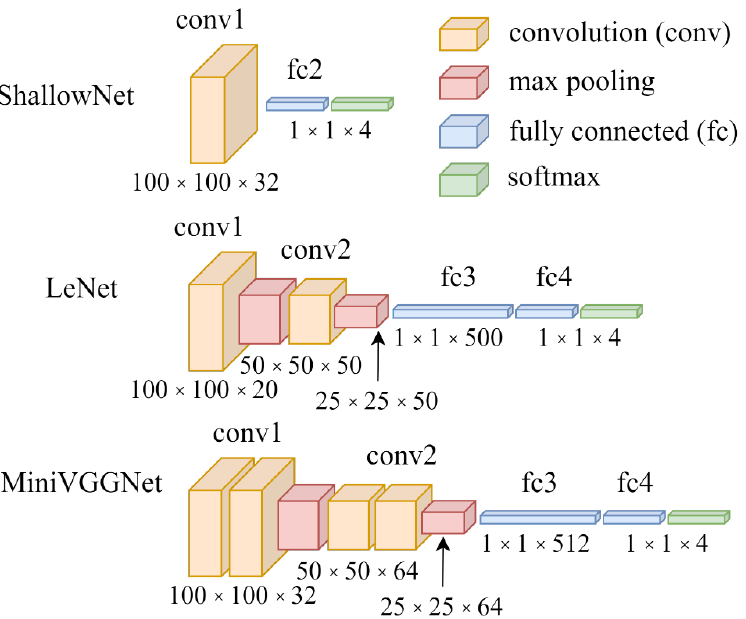
Figure 6. ShallowNet, LeNet, and MiniVGGNet model architecture design.